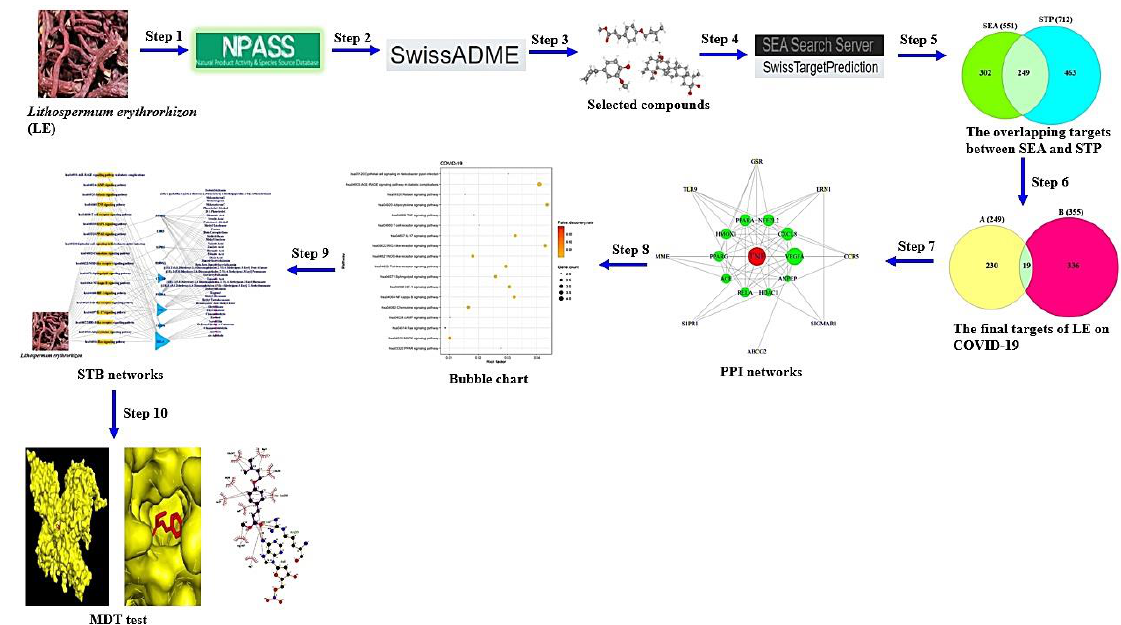
Figure 1. The workflow of this study.